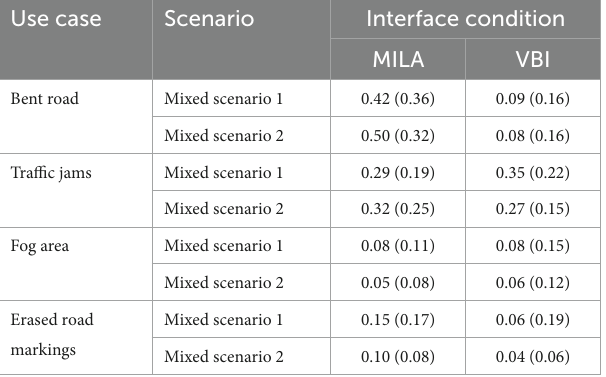
TABLE 5 Descriptive statistics [mean (SD)] of the proportion of visual fixation on the instrument’s cluster before the suspension of automation depending on the use case, scenario, and interface